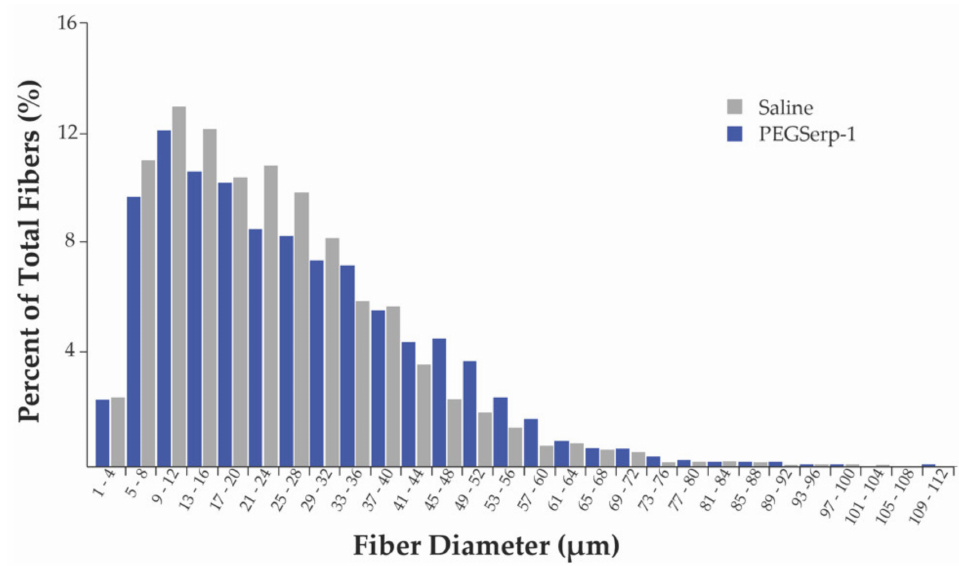
Figure 2. Distribution of Ferret’s minimal diameters of skeletal muscle fibers. Diaphragms from DKO mice treated with PEGSerp–1 or saline were stained with Masson’s trichrome. Images were taken at 40 × and diameters measured. Data are presented as a percentage of total fibers counted. PEGSerp- 1 treatment increased the percentage of myofibers with diameters of 33–64 µ m, and significantly increased overall average fiber diameter as compared to saline-treated muscle, p <